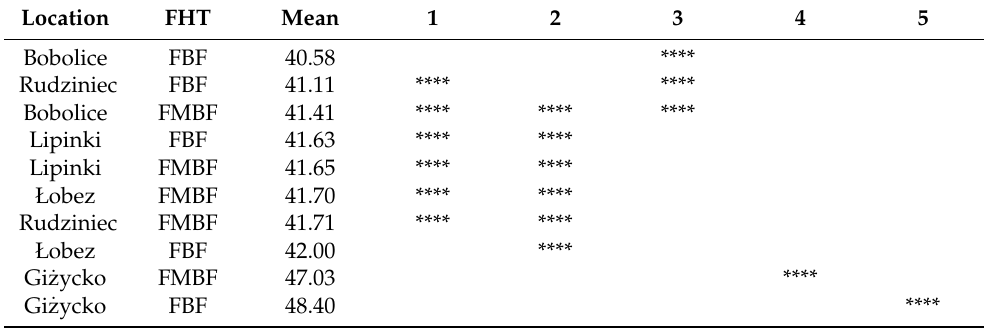
Table 12. Homogeneous groups in terms of mean wood hardness values for locations and habitat types (HSD Tukey’s range